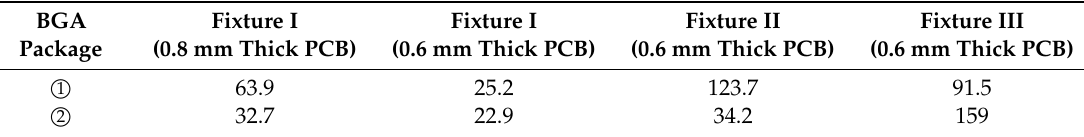
Table 3. Characteristic life (number of drops to failure) of the BGA solder joints with various fixtures.